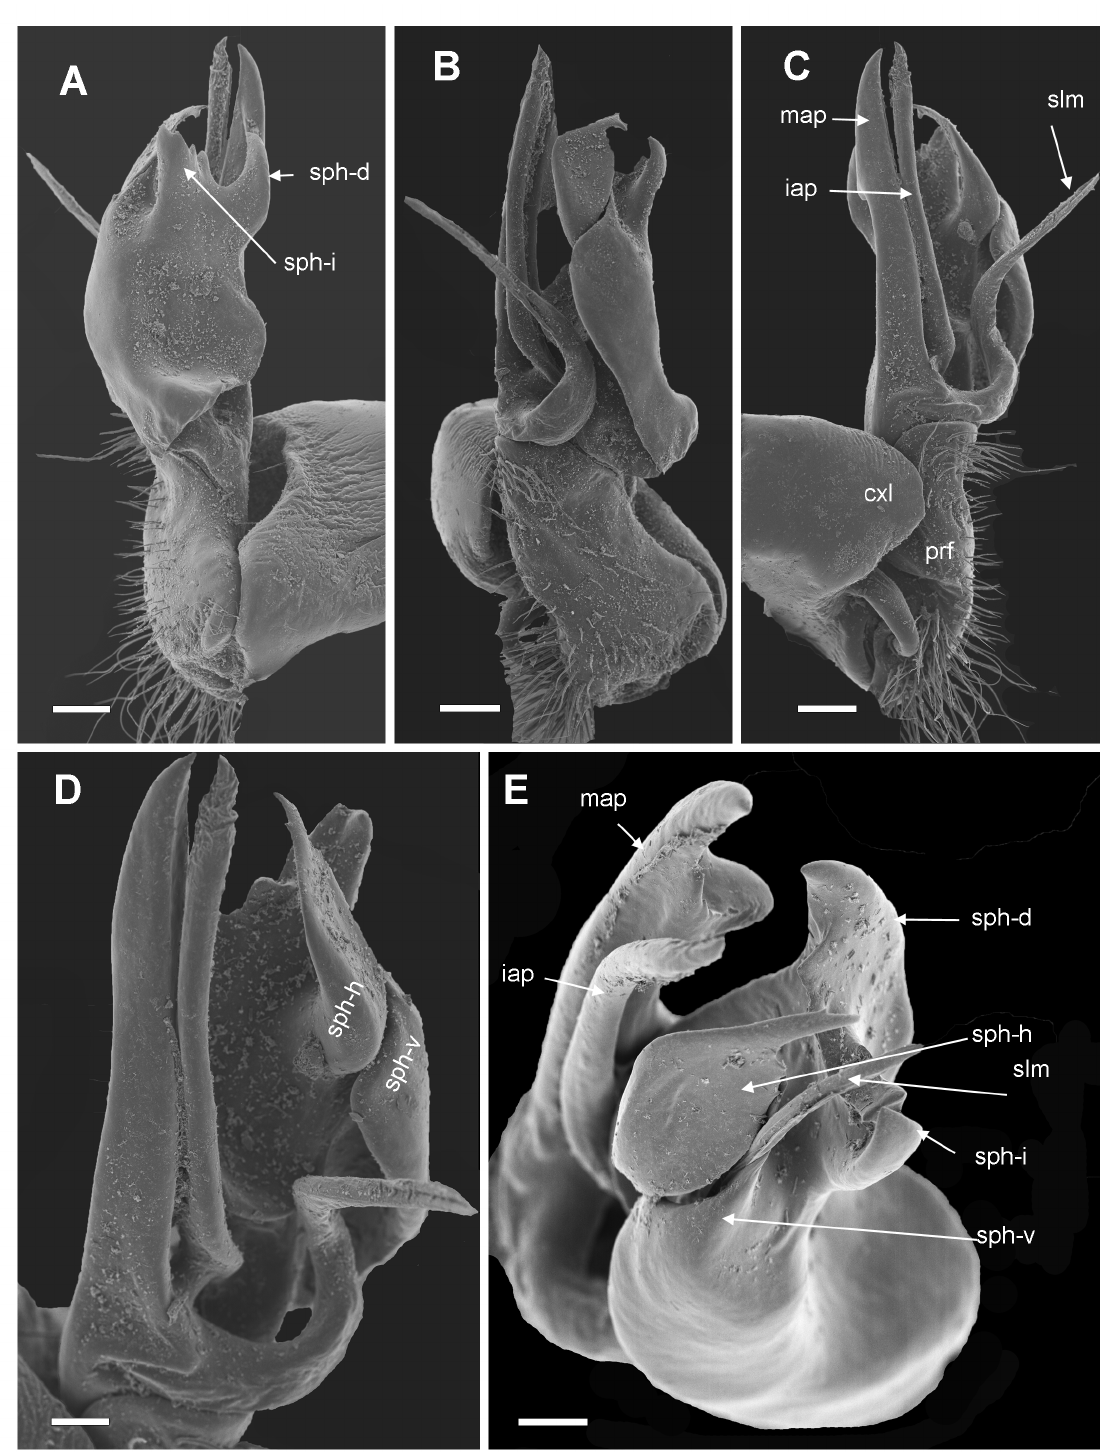
Fig. 21. Eviulisoma paradisiacum sp. nov. A–D . Paratype, left gonopod, solenomere dislodged from solenophore. A. Lateral view. B. Ventral view. C. Mesal view. D. Dorsal view. E . Another paratype, gonopod acropodite, apical (anterior) view, solenomere sticking out from solenophore slit. Abbreviations: cxl = coxal lobe; iap = intermediate acropodital process; map = mesal acropodital process; prf = prefemoral part; slm = solenomere; sph-d , sph-i , sph-v = dorsal, intermediate and ventral lobes of solenophore; sph-h = solenophore hook. Scale bars: A–C = 0.1 mm; D–E = 0.05